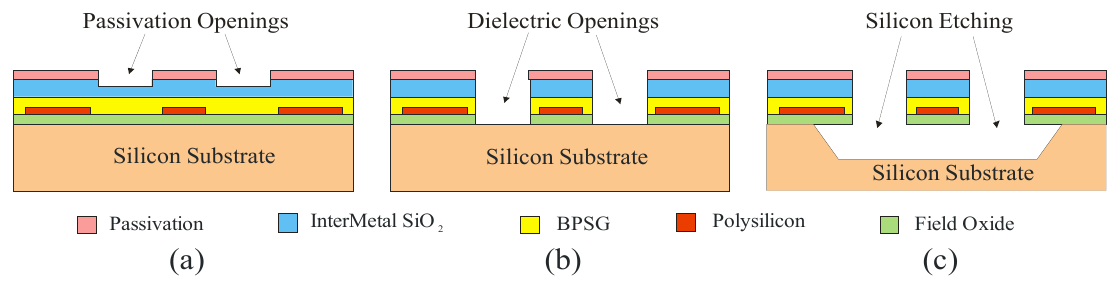
Figure 6. Schematic view of the post-processing: ( a ) passivation openings performed by the silicon foundry; ( b ) dielectric openings by reactive ion etching (RIE); ( c ) silicon anisotropic etching in TMAH solution.